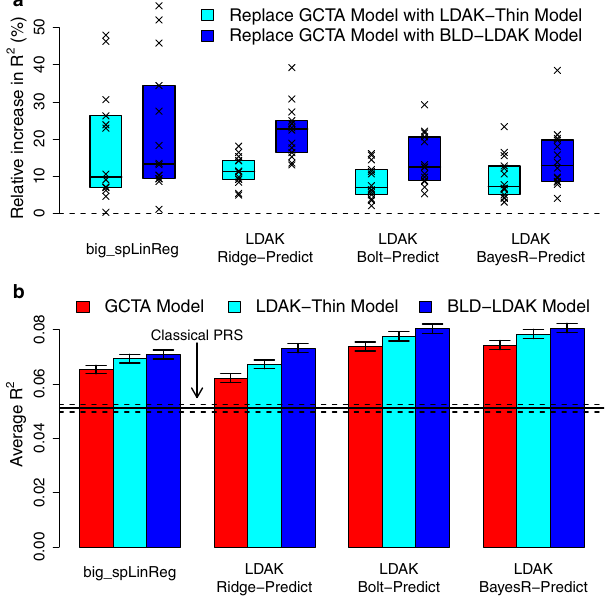
Fig. 2 Impact of changing the heritability model when using individual- level data. a We use our four new individual-level data prediction tools to construct PRS for the fi rst 14 UK Biobank phenotypes (using all 200,000 training samples). We measure the accuracy of each PRS via R 2 , the squared correlation between observed and predicted phenotypes across 20,000 test samples. Points report the percentage increase in R 2 for individual phenotypes when each tool is switched from assuming the GCTA Model to either the LDAK-Thin or BLD-LDAK Model (boxes mark the median and inter-quartile range across the 14 phenotypes). b For the same analysis as a , bars report R 2 averaged across the 14 phenotypes (vertical segments mark 95% con fi dence intervals). Colors indicate the assumed heritability model, while blocks indicate the prediction tool. The horizontal lines mark average R 2 for classical PRS and a 95% con fi dence interval. Source data are provided within the Source Data fi